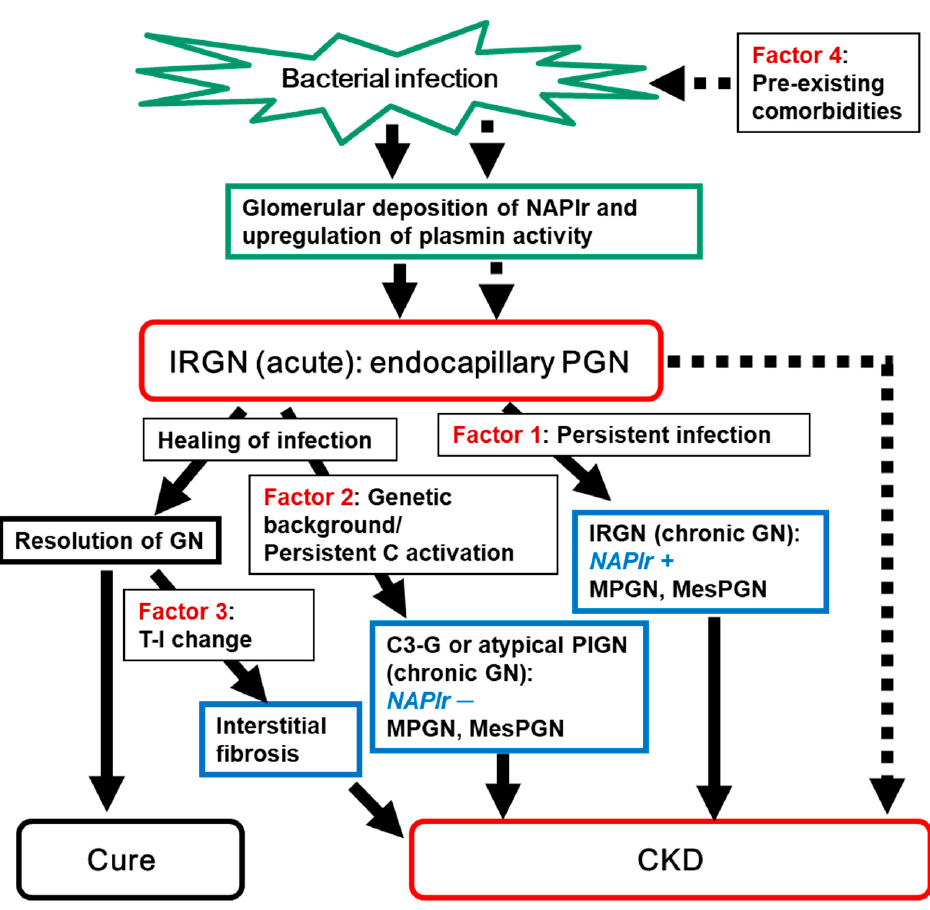
Figure 1. Summary of the concept of this review. Induction of IRGN and its outcome are summarized. IRGN may cure completely or may progress into CKD. Four factors that may contribute to the progression of IRGN into CKD are depicted. Solid arrow indicates the main flow of induction of IRGN and its outcome. While dotted arrow indicate the flow of patients with pre-existing comorbidities (Factor 4). NAPlr: nephritis-associated plasmin receptor; IRGN: infection-related glomerulonephritis; PGN: proliferative glomerulonephritis; GN: glomerulonephritis; C activation: complement activation; MPGN: membranoproliferative glomerulonephritis; MesPGN: mesangial proliferative glomerulonephritis; T-I: tubulo-interstitial; C3-G: C3 glomerulopathy; PIGN: postinfectious glomerulonephritis; CKD: chronic kidney disease.